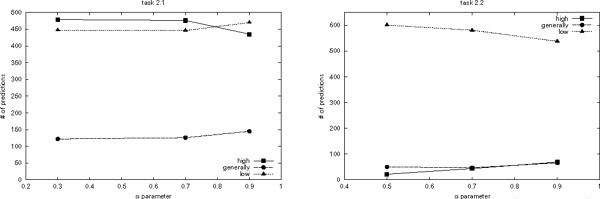
GO evaluation of FiGO predictions in tasks 2.1 and 2.2. A prediction was considered perfect when it provided high evidence of both GO term and protein. Thus, a prediction could provide high evidence of the GO term without being perfect. These charts disregard the protein evaluation and show the number of predictions submitted by FiGO to BioCreative tasks 2.1 and 2.2, which provided a high, generally and low evidence of the GO term for each value of α used.